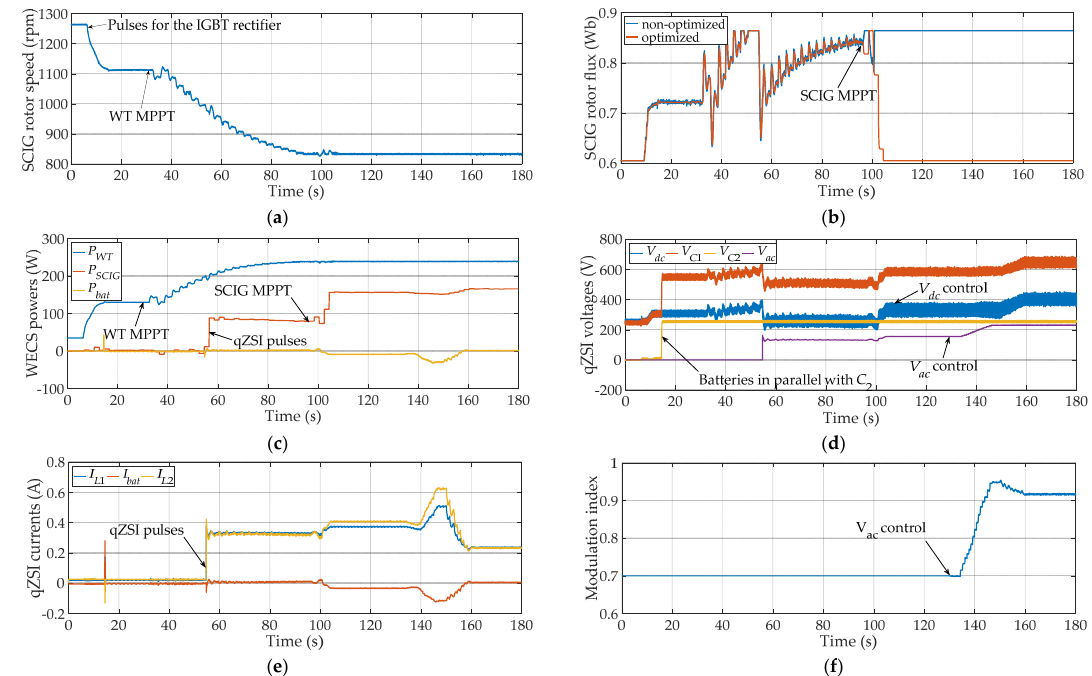
Figure 7. Dynamic responses during the startup procedure: ( a ) SCIG rotor speed; ( b ) SCIG rotor flux; ( c ) WECS powers; ( d ) qZSI voltages; ( e ) qZSI currents; ( f ) modulation index.